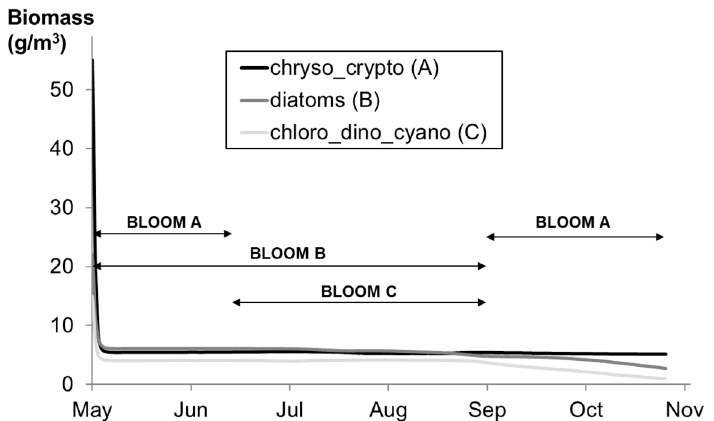
Figure 7. Simulation results for phytoplankton (lines) with the anticipated algae blooms added (blocks; legend: (A) chrysophytes and cryptophytes (B) diatoms and (C) chlorophytes, dinoflagellates and cyanophytes).